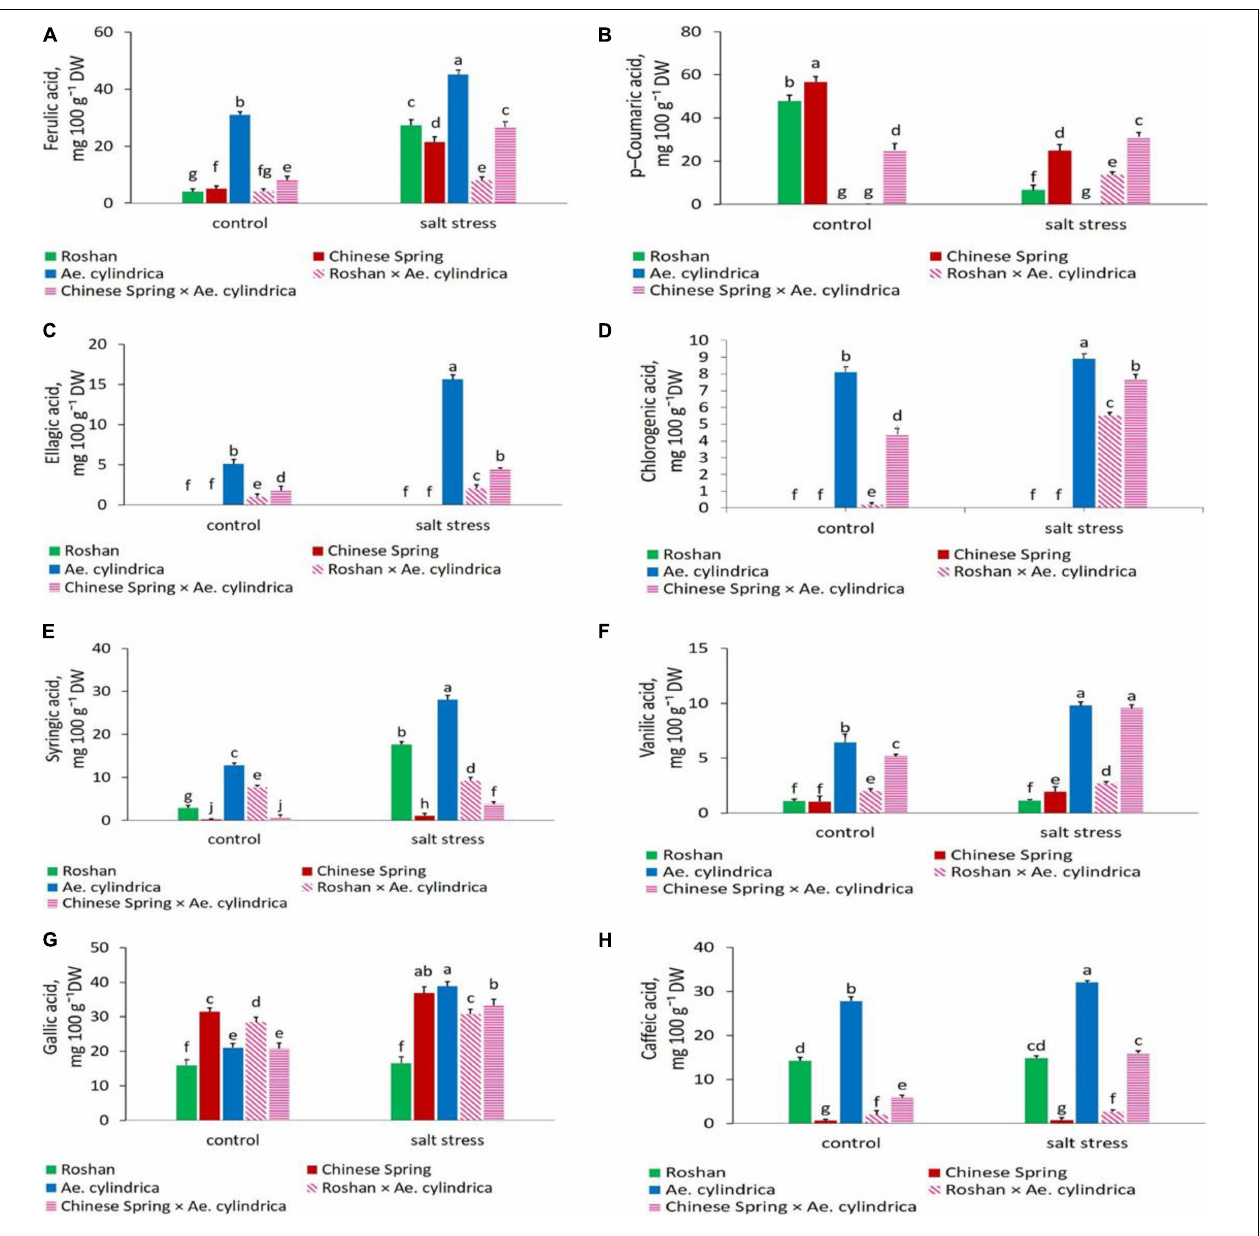
FIGURE 3 | Mean comparison of (A) ferulic acid, (B) p-coumaric acid, (C) ellagic acid, (D) chlorogenic acid, (E) syringic acid, (F) vanillic acid, (G) gallic acid, and (H) caffeic acid of parents ( T. aestivum “Roshan,” “Chinese spring,” Ae. cylindrica ) and their F 1 hybrid plants (amphidiploids) under control and salt stress conditions. Bars represent means ± SE and bars with the same letter do not significantly differ at p < 0.05 among the